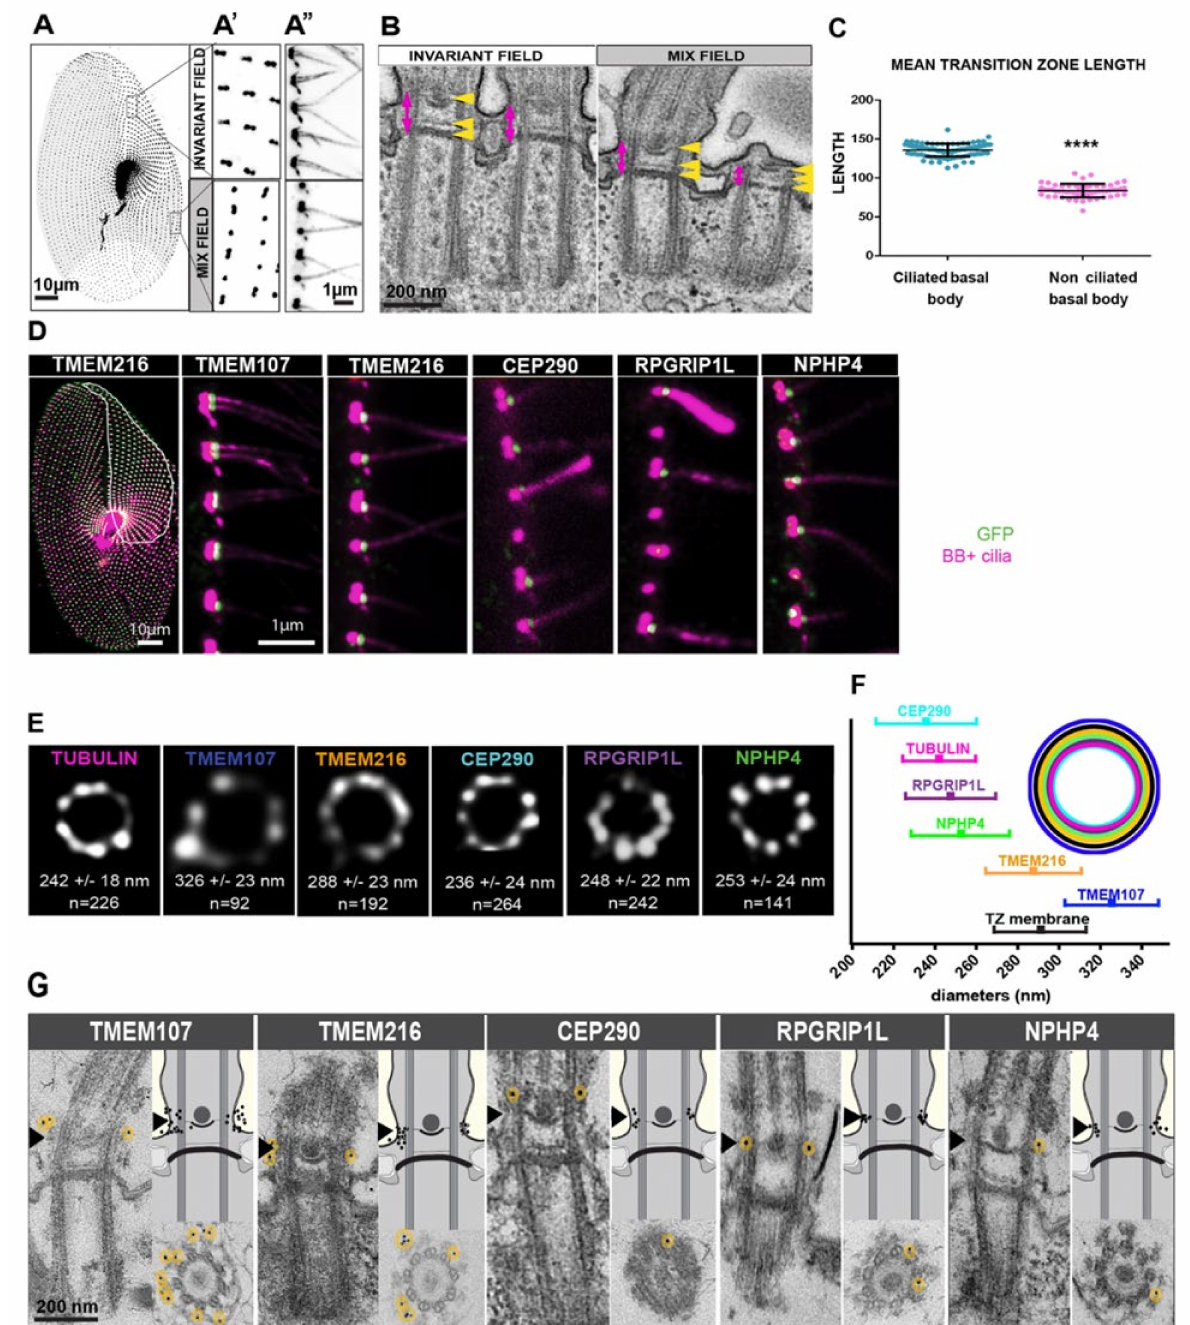
Figure 11. Localization of TZ proteins in Paramecium . ( A ) Paramecia labeled by 1D5 to identify the basal bodies showing the invariant field (double basal body units) at the anterior of the cell and the mixed field (both single- and double-basal body units) ( A’ ). The antibody also decorates the cilia ( A” ), scale bars are labeled. Electron microscopy images show longitudinal sections of these basal bodies in the invariant (left) and mixed (right) fields. ( B ) The yellow arrows show the terminal plate (bottom), the intermediate plate (middle) and the axosomal plate (top) present in the TZ (pink vertical double-arrows). Note that the basal body on the far right from the invariant field shows a shorter, more compressed TZ, as this basal body does not have a cilium, scale bars are 200 nm. ( C ) Graphical representation of the mean length of the TZ in ciliated and non-ciliated basal bodies (56 ciliated and 100 non-ciliated basal bodies were measured, **** p < 0.001, unpaired 2-tailed t -test. ( D ) Paramecium expressing one of the five different TZ proteins (TMEM107, TMEM216, CEP290, RPGRIP1L, and NPHP4) tagged with GFP. Basal bodies are also stained (pink, 1D5), invariant zone is highlighted in white on the